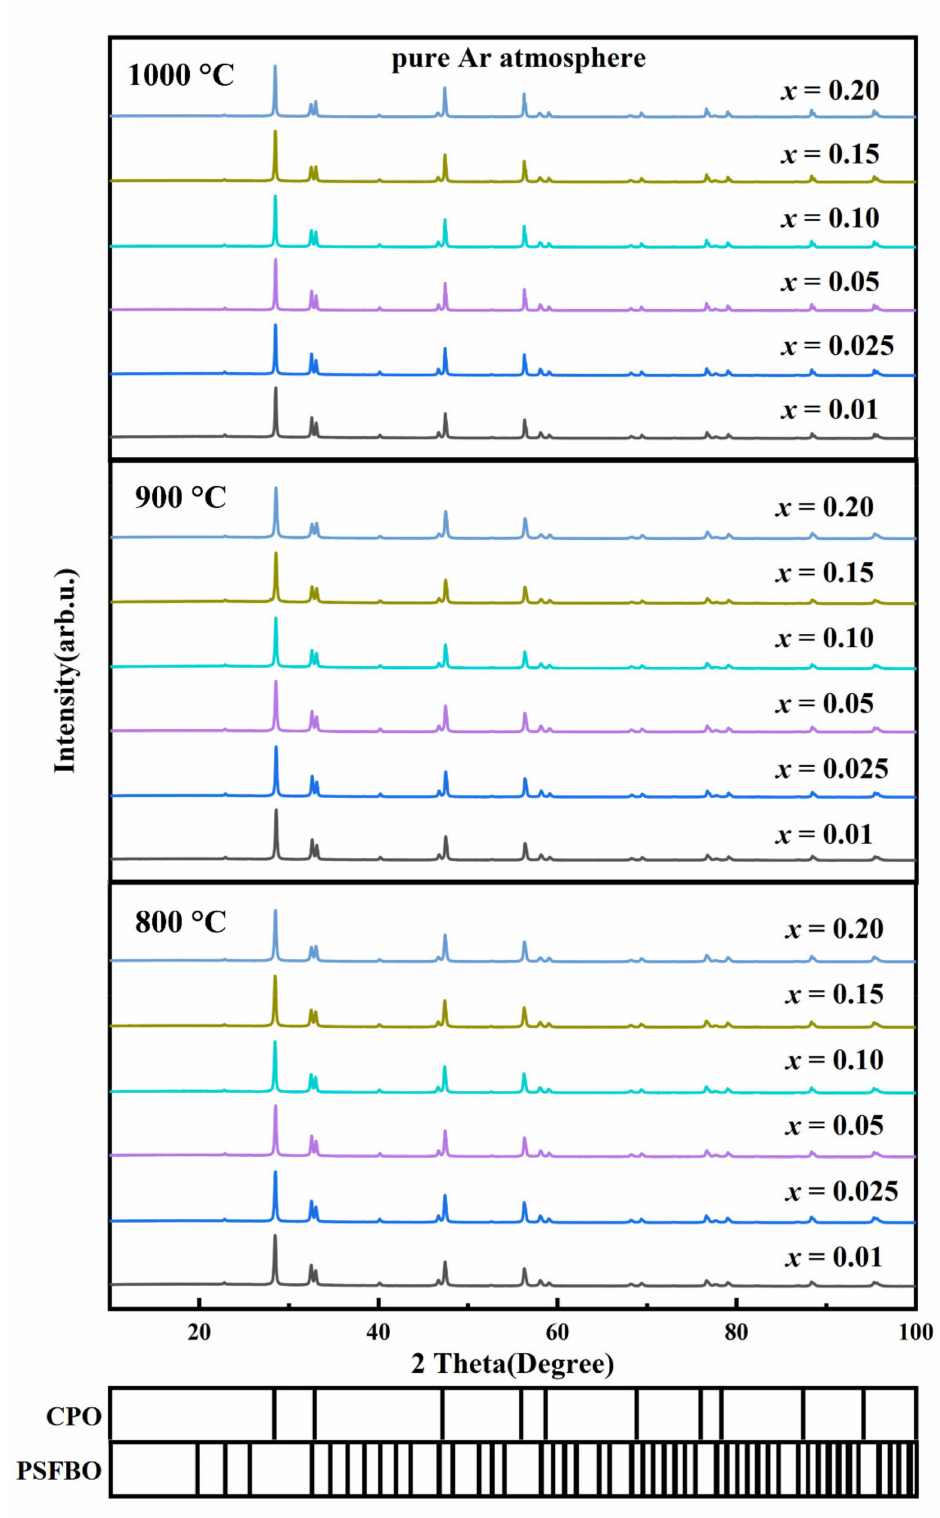
Figure 7. XRD patterns of the obtained 60CPO-40PSF 1 − x B x O powders after being calcined under pure Ar gas at 800, 900, and 1000 ◦ C for 24